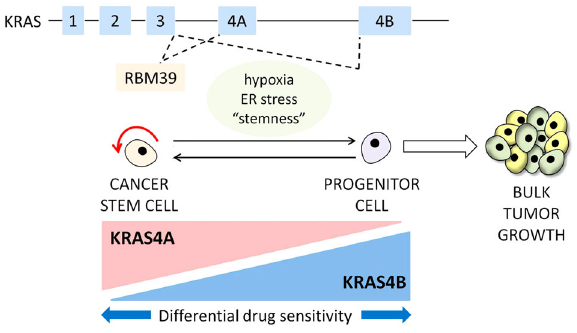
Fig. 7 Model for control of stem-progenitor cell transition by KRAS4A/4B splicing. KRAS4A is enriched in the cancer stem cell population, whereas KRAS4B is more ubiquitously expressed in stem and progenitor